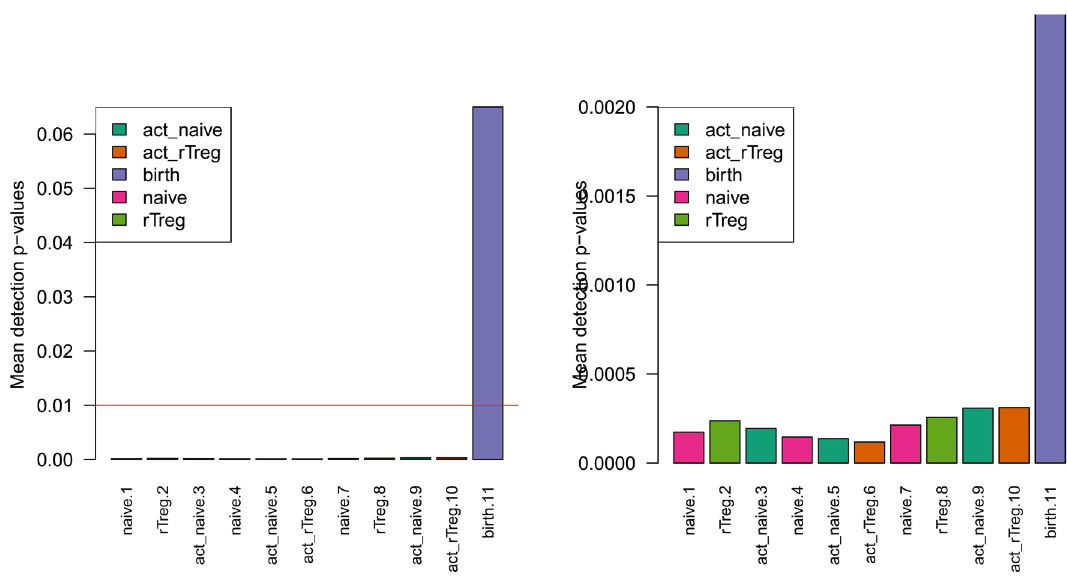
Figure 2. Mean detection p-values summarise the quality of the signal across all the probes in each sample. The plot on the right is a zoomed in version of the plot on the